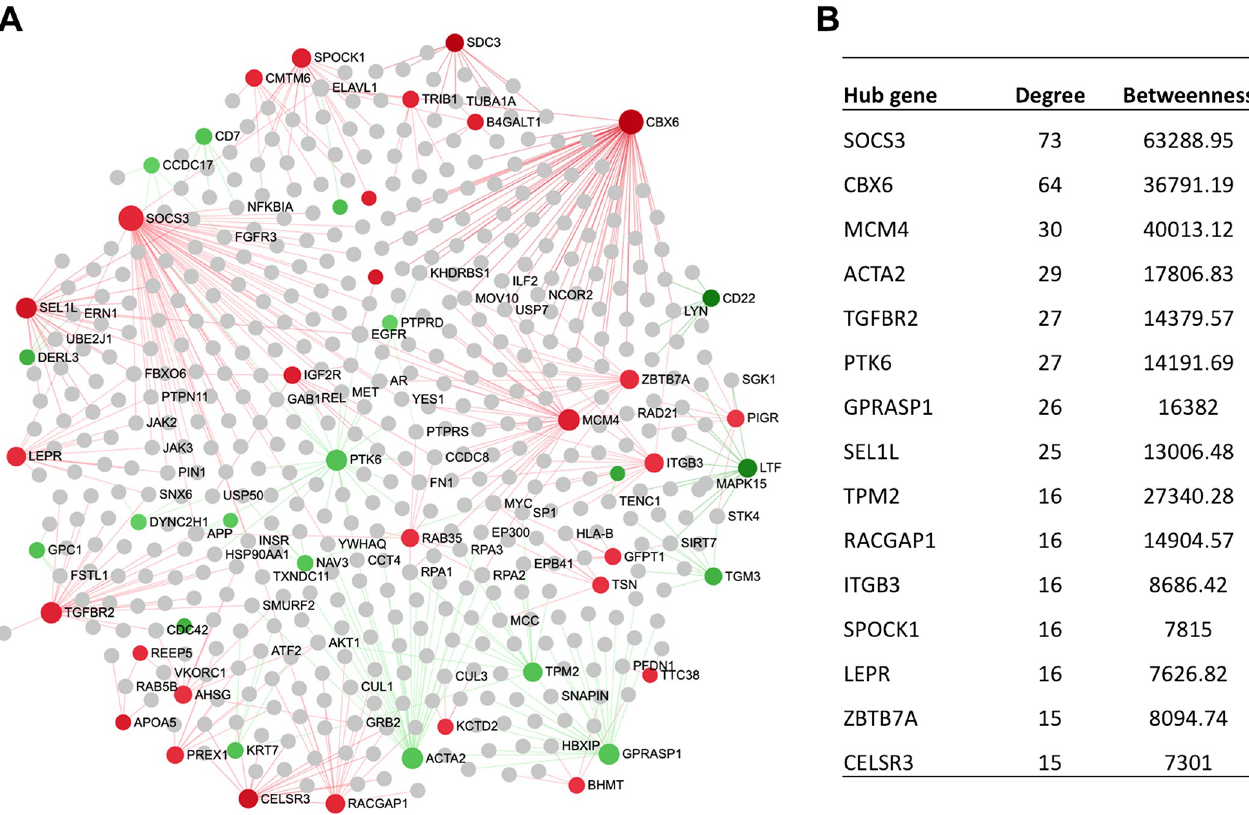
were analysed to validate their segregation and association in the studied sheep population TGFBR2 and LEPR were associated with fatty acid composition (Table 6) in the studied sheep population.